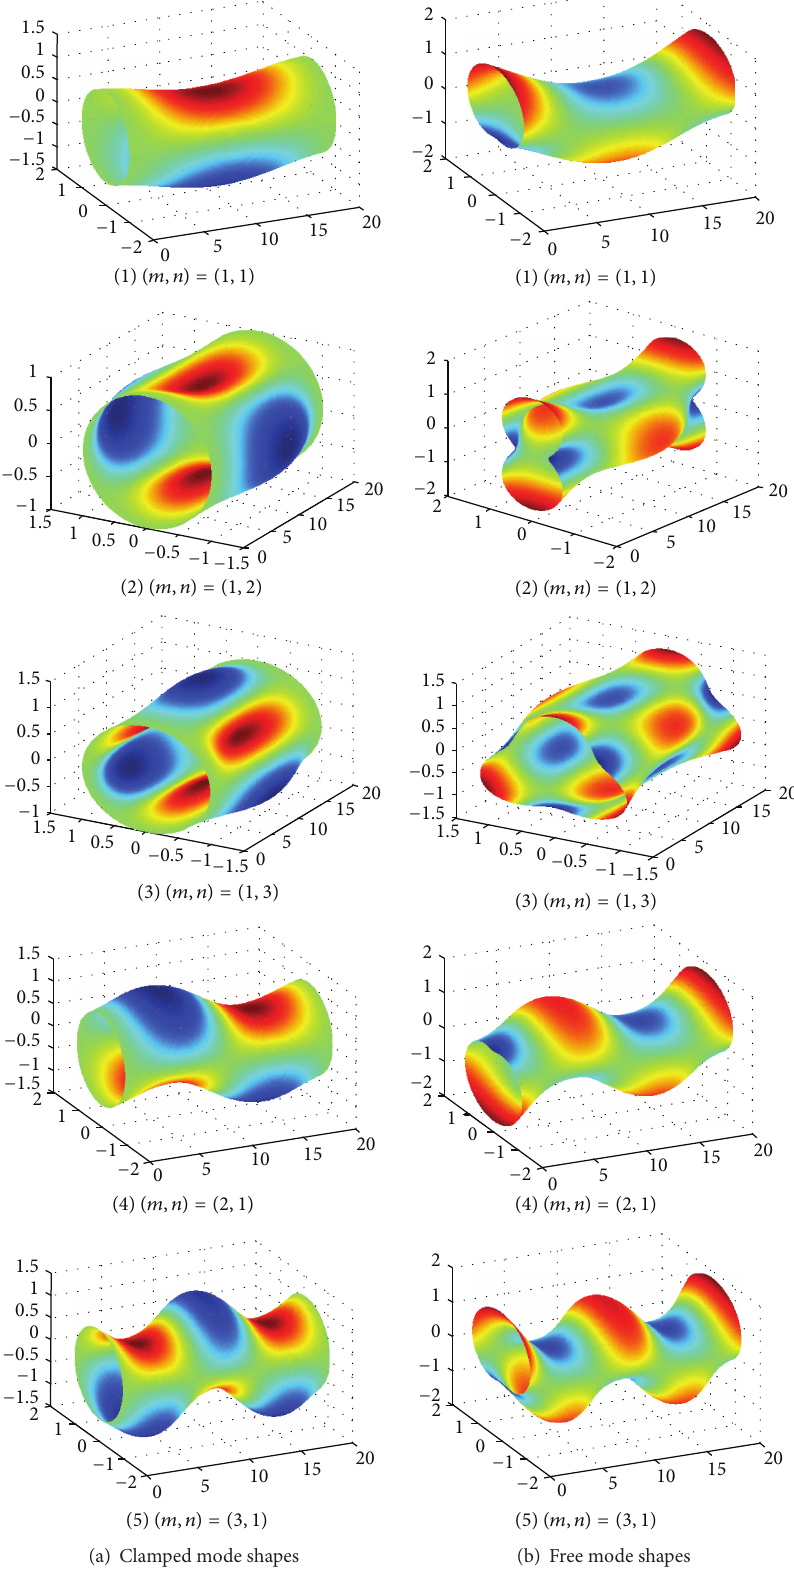
Figure 5: Some selected free mode shapes and clamped mode